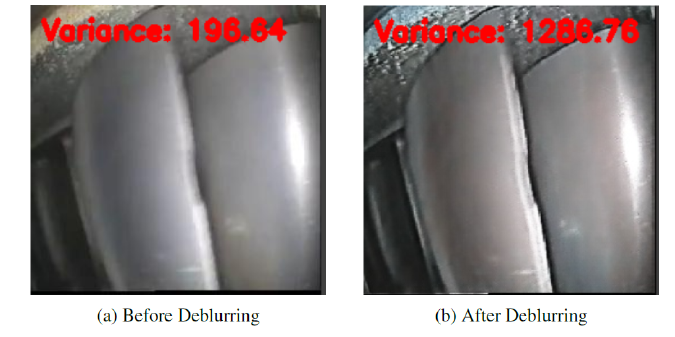
Figure 6. Results after